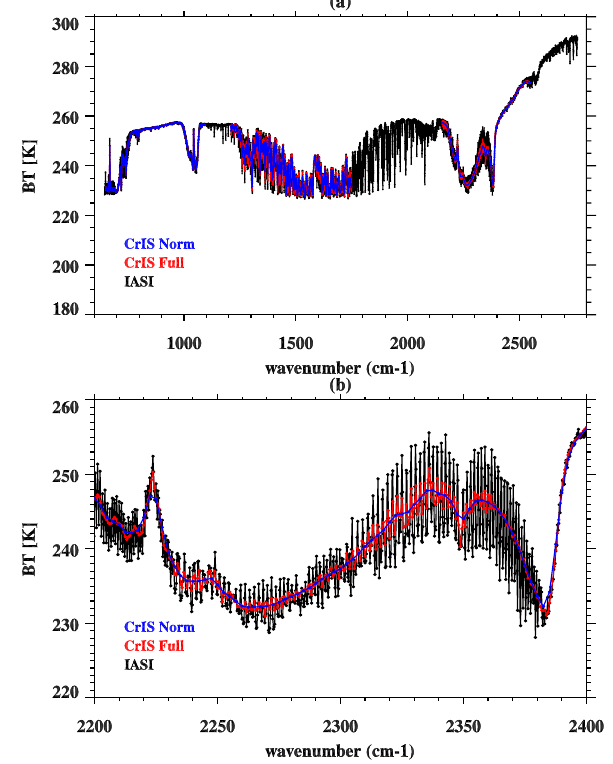
Figure 6. (a) CrIS and IASI spectra for paired CrIS and IASI SNO FOVs on 27 August 2013 and (b) enlarged plot at the spectral range from 2200 to 2400cm − 1 .